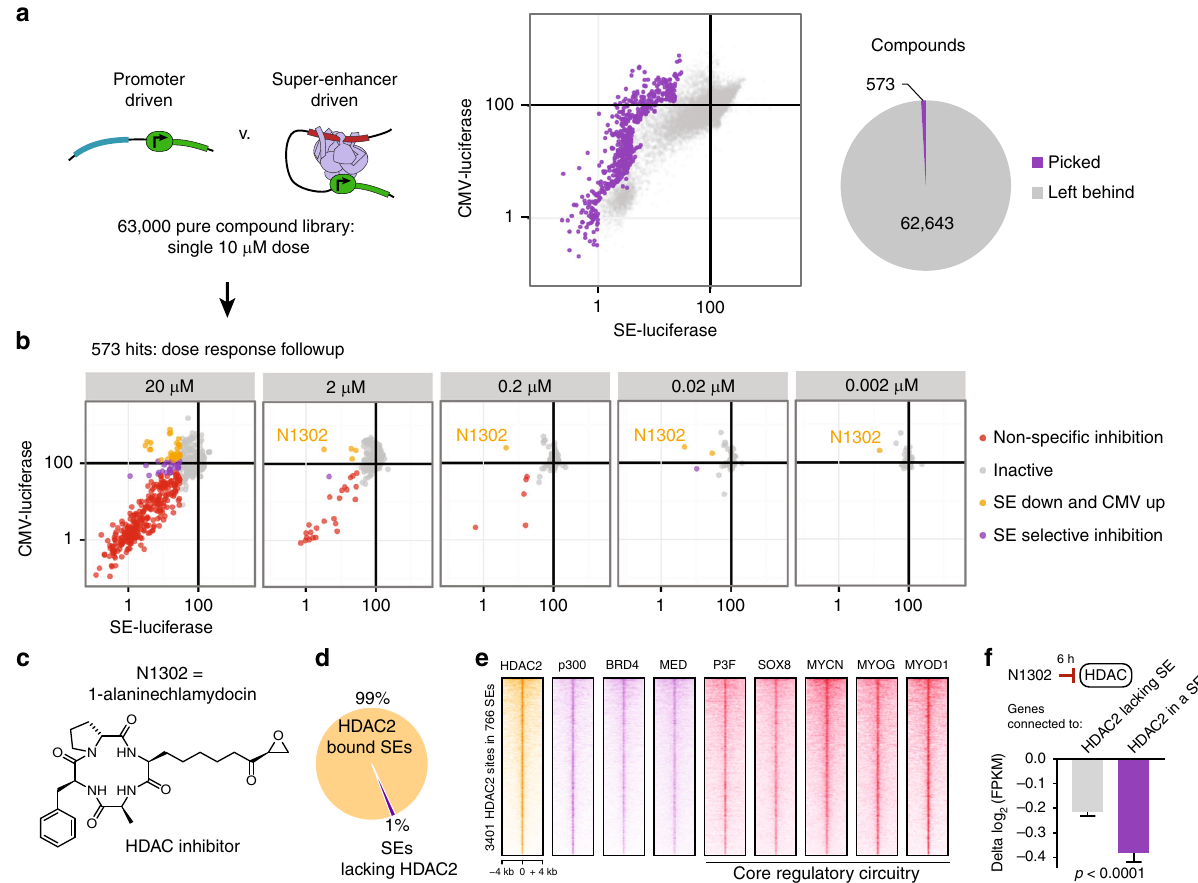
Fig. 2 HDAC is a key chemical vulnerability core regulatory TF-driven transcription. a First pass screening of 63,000 pure compounds against constitutive promoter-driven (CMV) and SE-driven luciferase. Assay was performed after 24 h of 10 µ M exposure to each drug in duplicate. 573 of the most selective small molecules were chosen for follow-up screening. b Validation of 573 hits by dose – response screening identi fi ed the molecules that continued to perform as SE-selective transcriptional inhibitors at lower doses, most notably compound N1302. Points represent the mean of four technical replicates. c Structure of N1302, 1-alaninechlamydocin, an epoxide-containing cyclic tetrapeptide known to potently inhibit histone deacetylases. d HDAC2 occupies virtually all super enhancers. Pie chart depicts super enhancers in RH4 cells either bound (99%) or unbound (1%) by HDAC2 assessed by overlap of high- con fi dence ( q < 10 − 9 ) ChIP-seq peaks. e HDAC2 sites ( n = 3401) in SEs ( n = 766) are co-bound by enzymatically opposing HAT (p300), BRD4, mediator, and core regulatory TFs. ChIP-seq signal is plotted as heatmaps of 8 kb surrounding each HDAC2 peak, as detected in FP-RMS (RH4 cells). f HDAC inhibitor has selective transcriptional impact on SE-associated, HDAC2 proximal genes. N1302 was dosed in RH4 cells for 6 h at 1 µ M. Error bars represent 95% con fi dence interval; P -value was calculated by Welch ’ s unpaired t